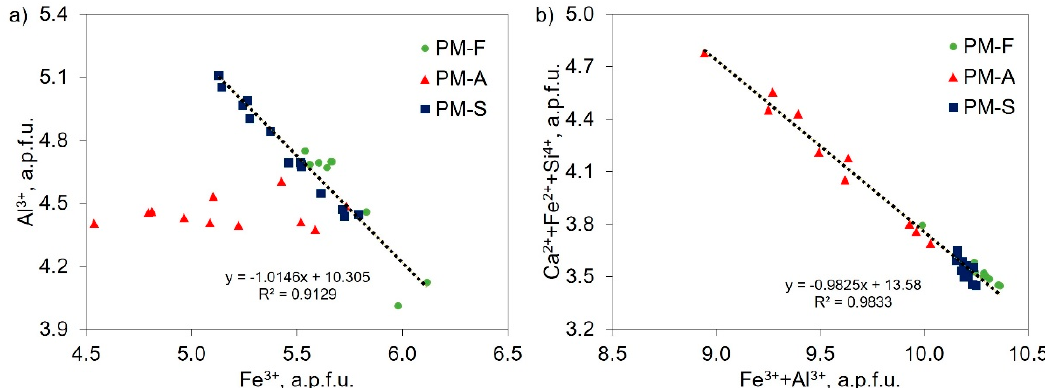
+ vs. Fe 3 + and ( b ) Ca 2 + + Fe 2 + + Si 4 + vs. Fe 3 + + Al 3 + . Figure 4. Element covariation diagrams for ( a ) Al 3+ vs. Fe 3+ and ( b ) Ca 2+ +Fe 2+ +Si 4+ vs. Fe 3+ +Al 3+. Figure 4. Element covariation diagrams for ( a ) Al 3